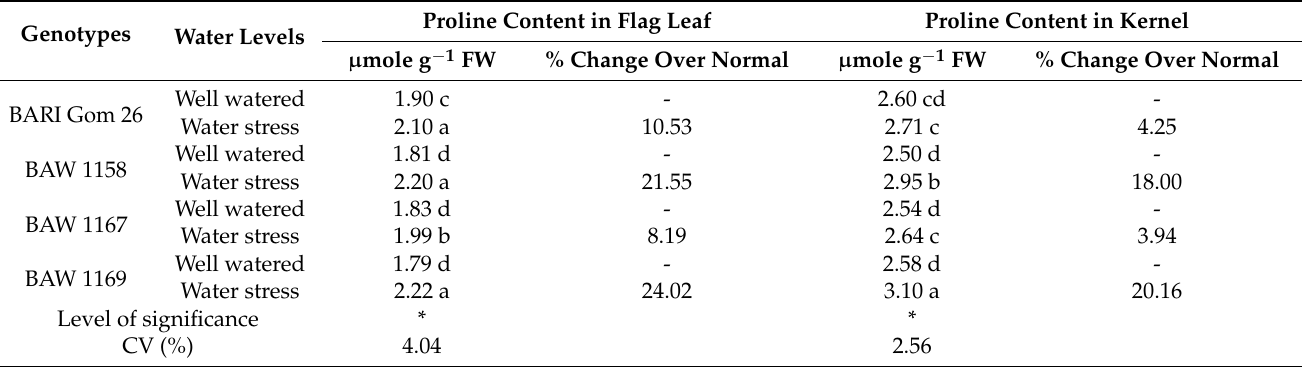
Table 9. Effect of DS on the proline content in flag leaf and kernel of wheat genotypes at 16 DAA.